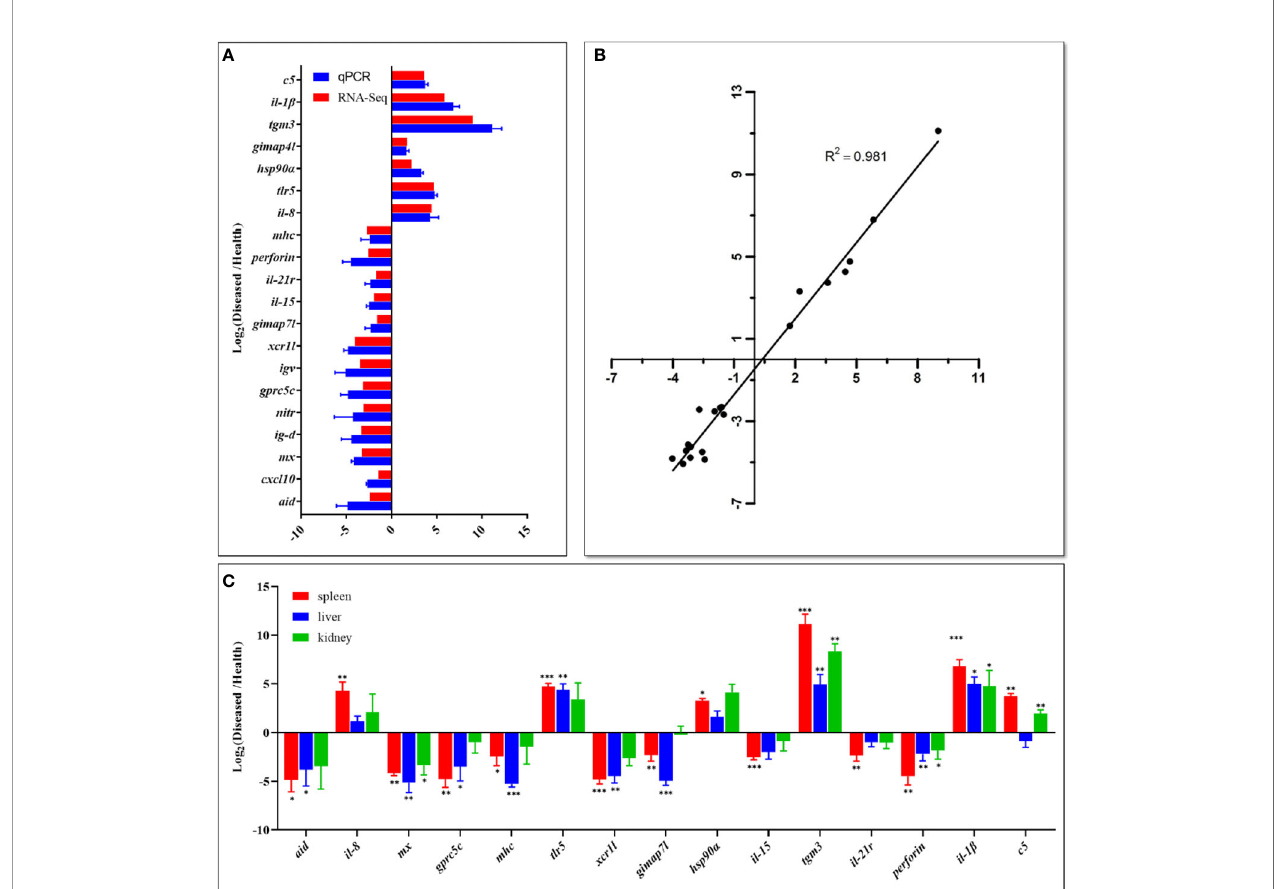
FIGURE 7 | Comparison of gene expression data between RNA-Seq and qPCR. (A) The relative expression levels of twenty DEGs detected by qPCR were compared with that of RNA-Seq. The X-axis represents the value of RNA ‐ Seq data and qPCR data, and the Y-axis represents the gene name. RNA-Seq data used log 2 fpkm values of diseased and healthy fi sh samples, and qPCR data are presented as mean ± standard deviation (n=3). The p value of all genes in qPCR was less than 0.01. (B) Correlation of qPCR and RNA-Seq data. The X-axis represents the RNA-Seq data, and the Y-axis represents the qPCR data. The Pearson product- moment correlation coef fi cient (R 2 ) of each plot was shown as an indication of positive linear correlation between the two methods. (C) The expression patterns of fi fteen selected DEGs in the spleen, liver, and kidney. qPCR data are presented as mean ± SD (n=3). The X-axis represents the gene name, and the Y-axis represents the value of qPCR data. Statistically signi fi cant differences in gene expression levels between healthy and diseased fi sh in each tissue type are marked with asterisks (* means p < 0.05, ** means p < 0.01, *** means p < 0.001). The raw data (Ct values) of qPCR is in Supplementary Table 6